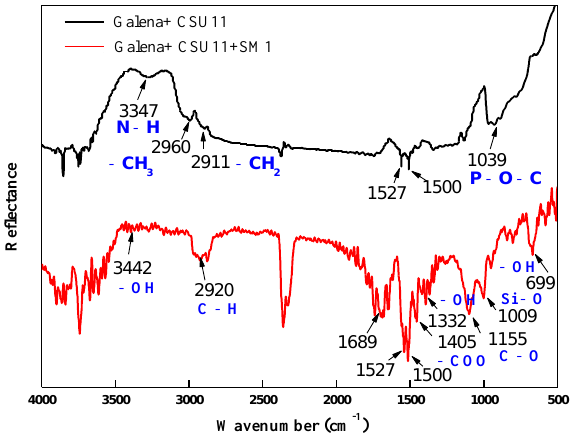
Figure 10. FT-IR spectra of chalcopyrite treated with the collector CSU11 and the depressant SM1 at natural pH (CSU11 concentration 50 mg/L, SM1 concentration 200 mg/L).